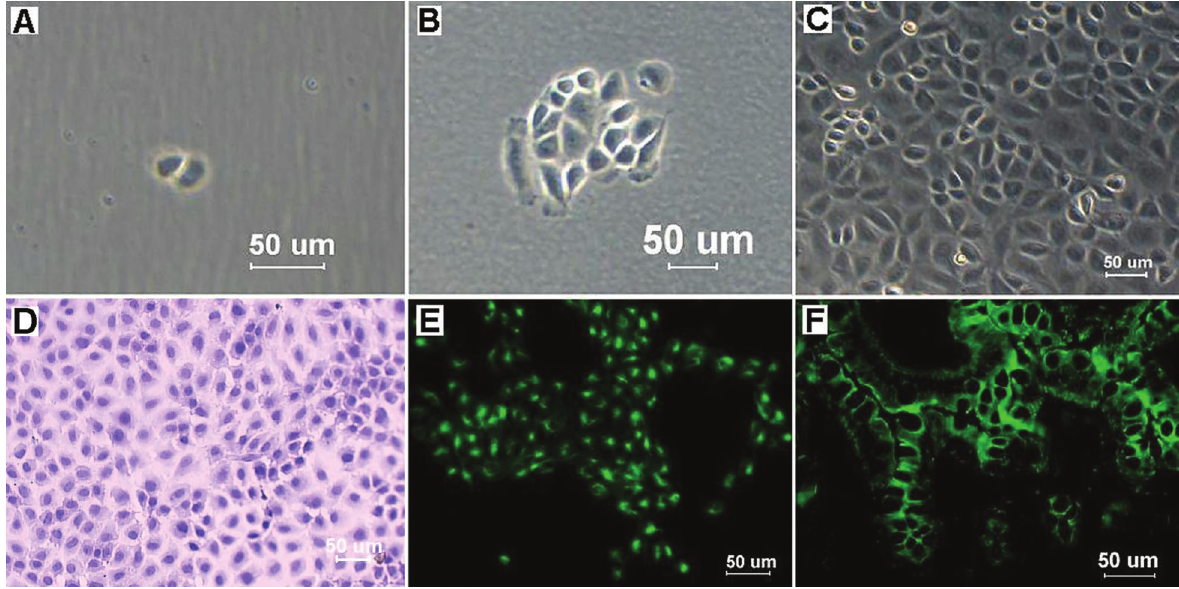
Figure 2. Preparation of cell clones and morphology characterization of mouse intestinal epithelial cells (IECs). Mouse IEC clones were obtained by limiting dilution, and light micrographs showed cell clones at 2 days ( A ) and 5 days ( B ) after seeding. The morphology of mouse IECs at the 35th passage is shown in ( C ). Hematoxylin and eosin staining showed that mouse IECs formed a cobblestone monolayer, and each cell was polygonal and fl attened with a large, oval nucleus ( D ). The mouse IECs were strongly positive for cytokeratin 18 ( E ), and the mouse intestinal tissues also reacted with the cytokeratin 18 antibodies as the positive control ( F ).